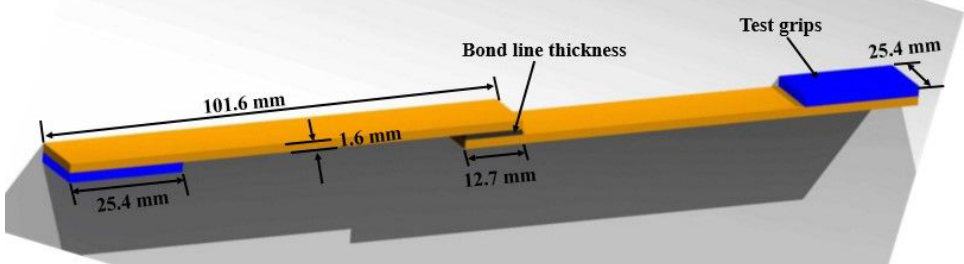
Figure 3: Specimen configuration of single-lap shear adhesive joints of aluminium